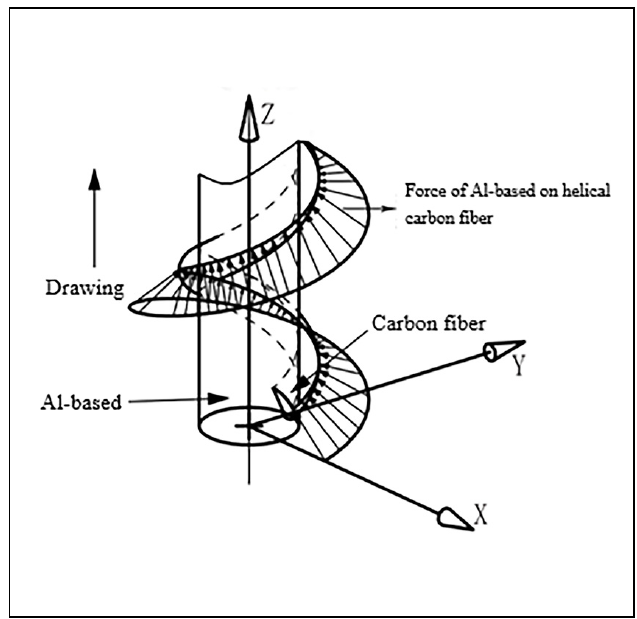
Figure 12. Force distribution of aluminum matrix on carbon fiber along the helix.